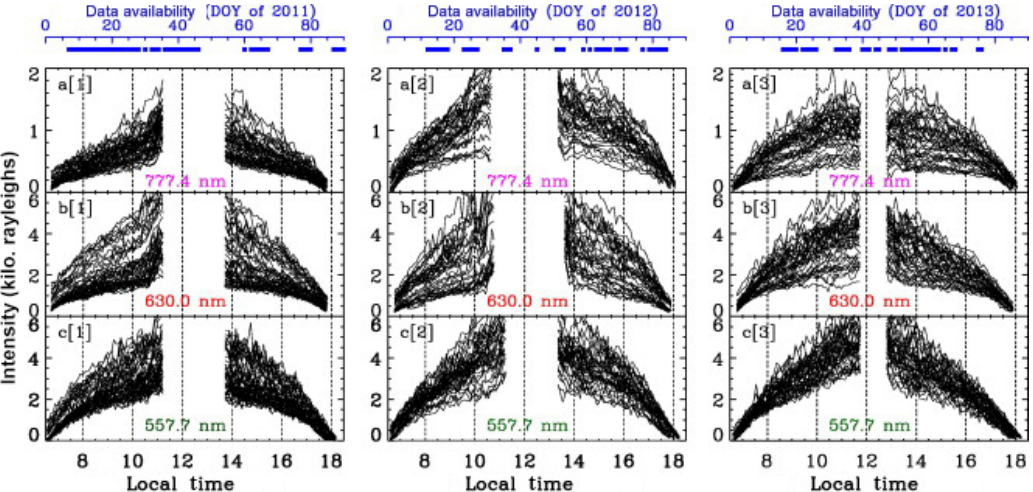
Figure 7. Reproduced from Fig. 1 of Laskar et al. (2015). The diurnal variations of the dayglow emission intensities for the 3 years 2011– 2013 (left to right) and for the three wavelengths (top to bottom) are shown. The additional axes at the top represent the day of the year (DOY) on which dayglow data are available. It can be noted that the diurnal intensity pattern of all the emissions show a symmetric, broad solar zenith angle dependence in these years unlike the ones reported in the present data from the year 2014, in which deviations from solar zenith angle dependence seem to exit (Fig. 3d, e, f).